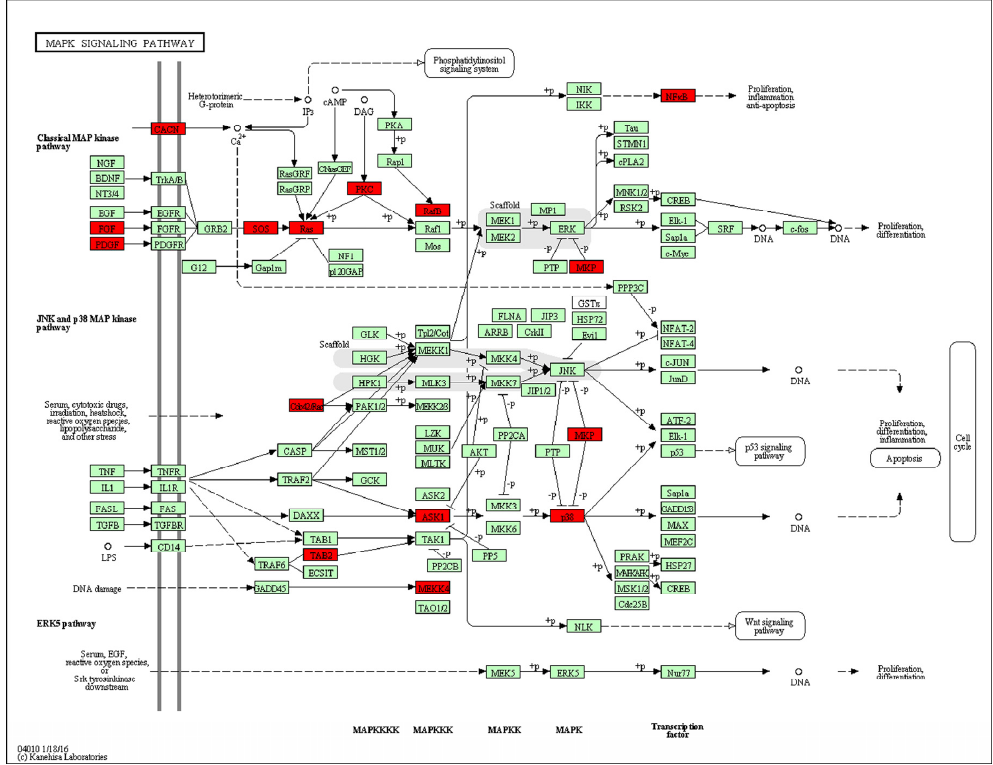
Figure 5. Promoter-specific DNA methylation of genes in the Kyoto Encyclopedia of Genes and Genomes (KEGG) mitogen-activated protein kinase (MAPK) signaling pathway. The red box indicates hypomethylated gene promoters and the map was provided by KEGG Pathway